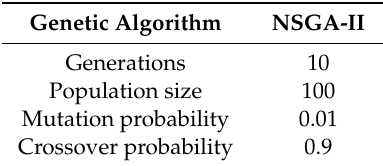
Table 2. Optimization